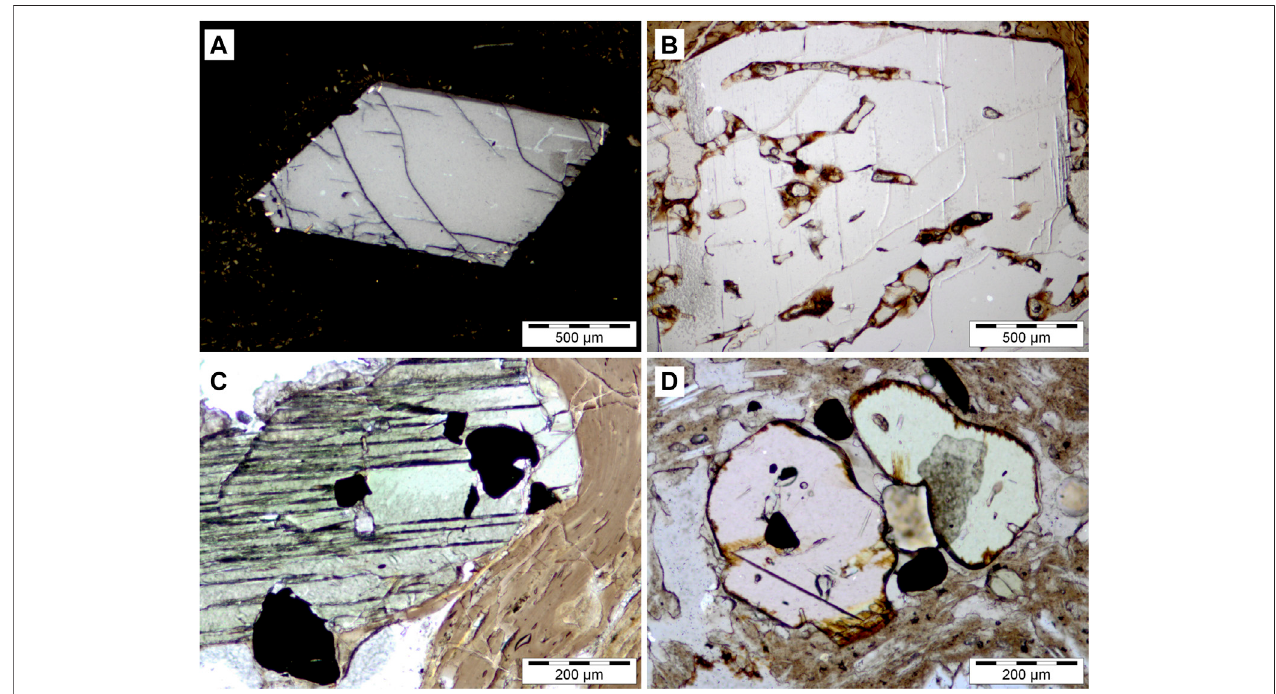
FIGURE11| Representative photomicrographsofmineral phases from theAngra and Lajes ignimbrites. (A) Euhedralalkali feldspar phenocryst. (B) Alkali feldspar phenocryst with partially resorbed core fi lled by vesicular glassy pockets. (C) Subhedral clinopyroxene phenocryst with Fe-Ti oxide inclusions. (D) Olivine phenocrysts with reaction rims and inclusions of Fe-Ti oxides and small acicular